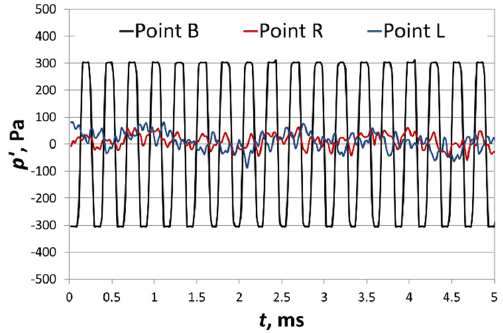
Figure 19. Acoustic pressure fluctuations for velocity in the channel equal to 70 m/s—experimental data.